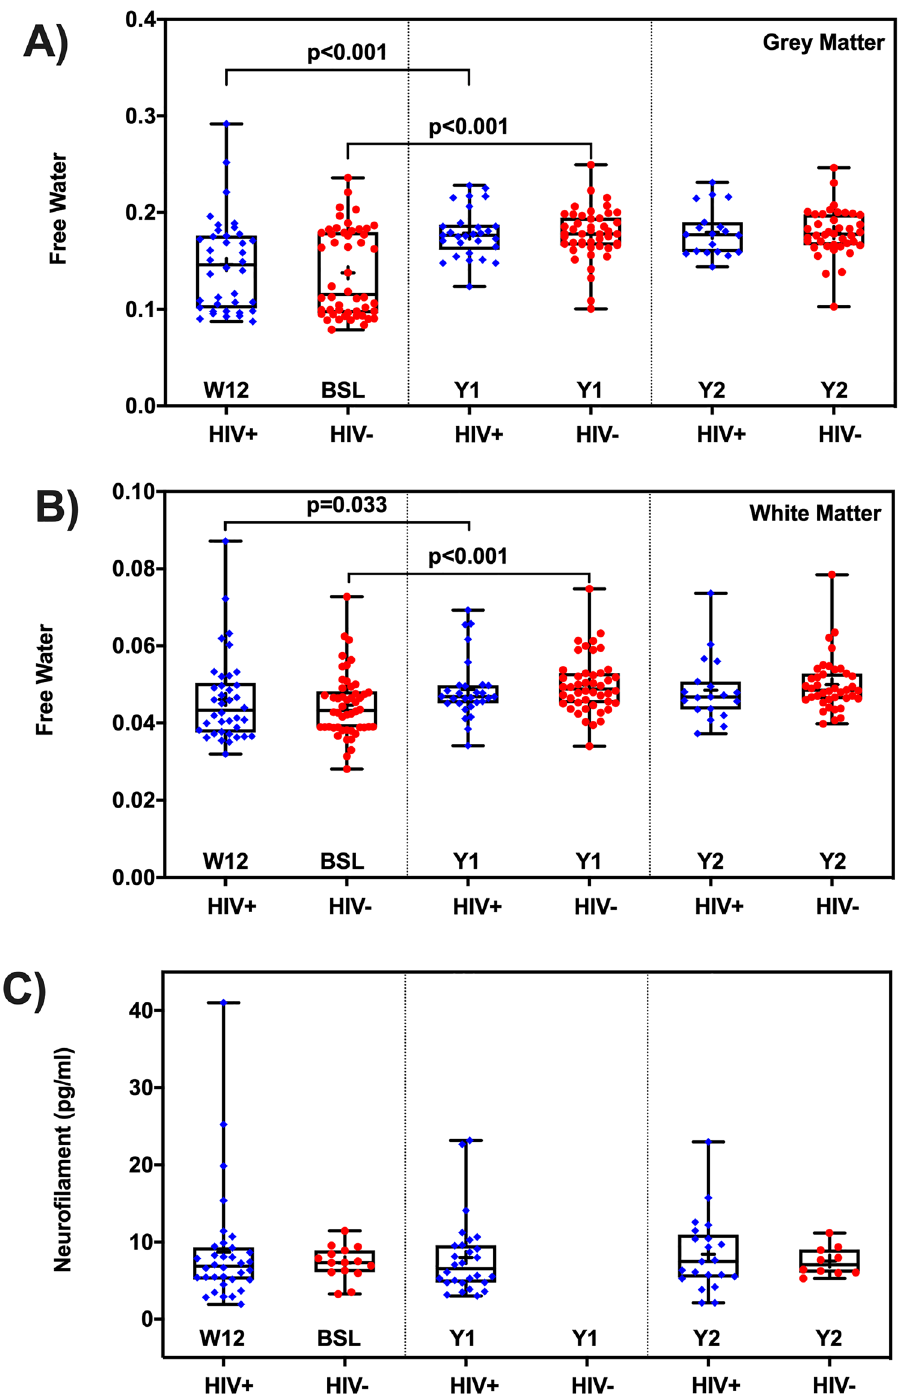
Figure 3. Long term effect of cART treatment on free water and neurofilament light chain. The box-and- whisker plots illustrate the comparison of free water (FW) index between the HIV+ and HIV- participants, and the temporal trends of FW from baseline and follow-up visits in ( A ) gray matter (GM), ( B ) white matter (WM); ( C ) average NfL concentration. There is no significant between-cohort difference of long-term temporal progression in FW (in GM and WM), and NfL. Note, BSL, baseline; W12, week-12 (new BSL for HIV+); Y1, year-1; Y2, year-2; NfL data were not collected at Y1 for HIV− participants. + sign indicates the mean FW at each time point and cohort. Significant differences are also